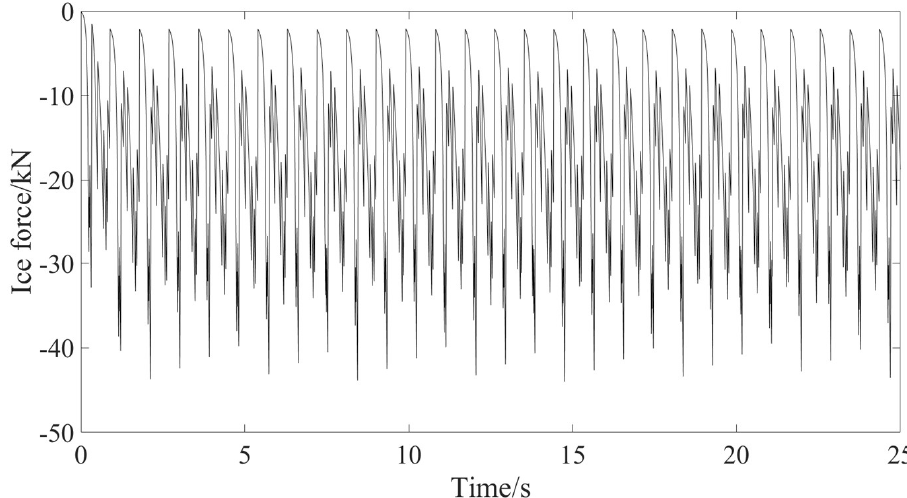
Figure 7. Time history curves of total ice force in case 1.